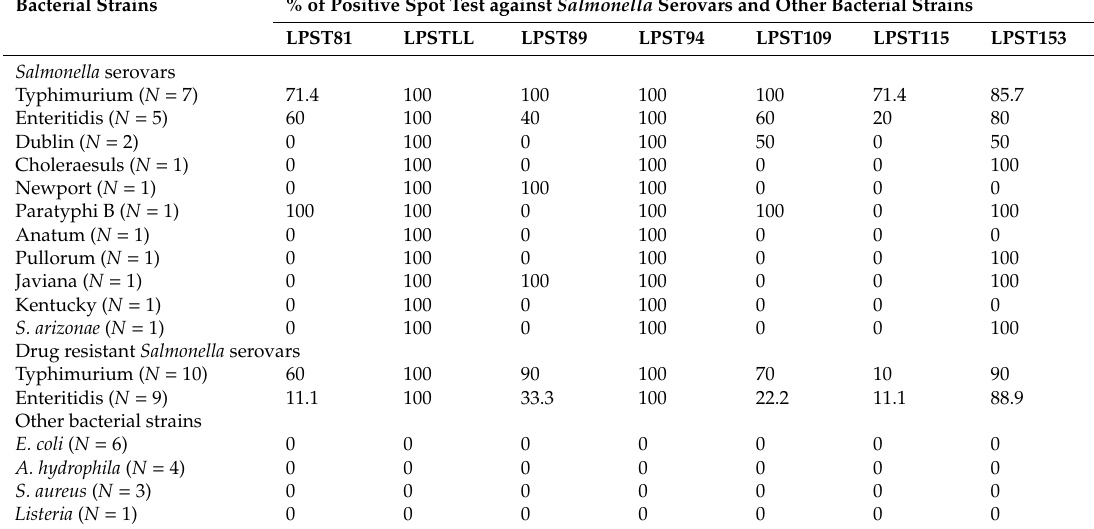
Table 2. Sensitivity of di ff erent Salmonella serovars and other bacterial strains to lyse by selected phages determined by spot